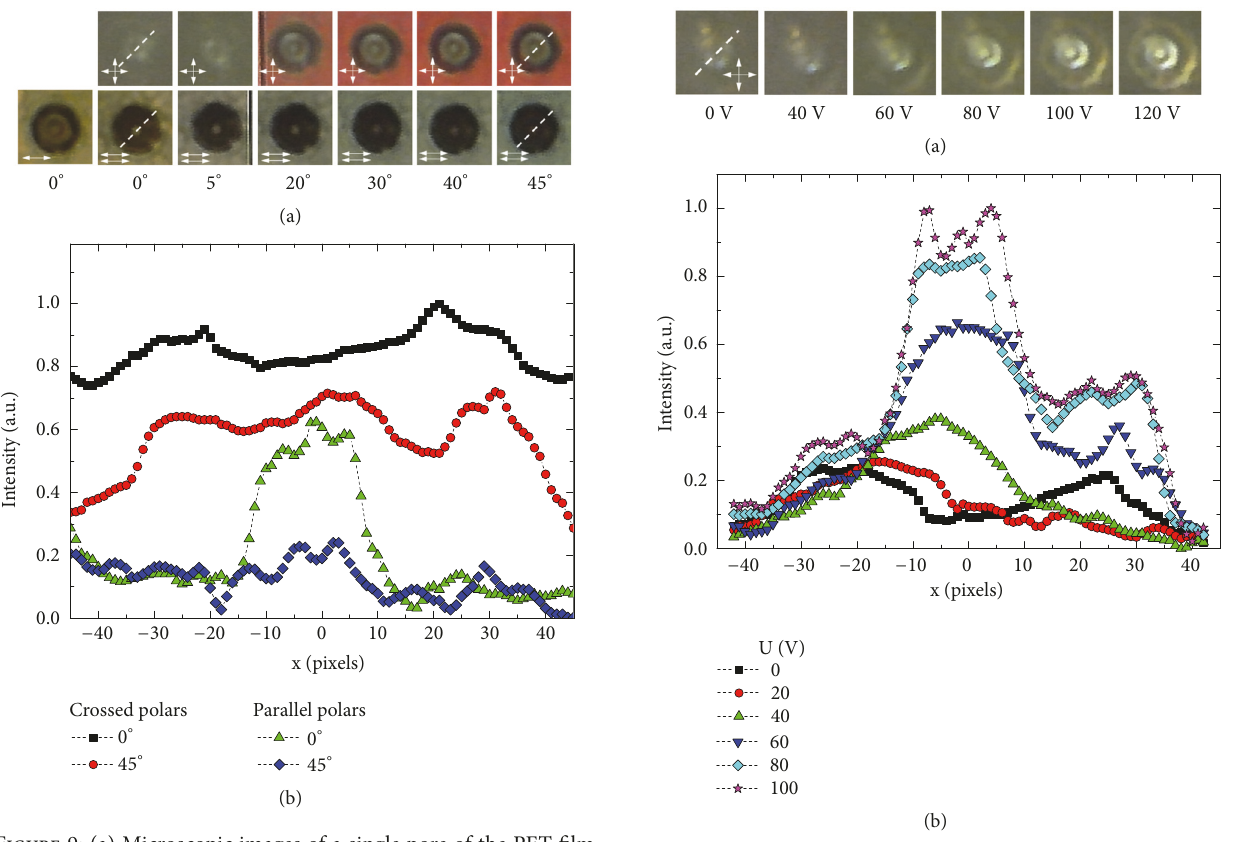
Figure 10: (a) Microscopic images of a single pore filled with LC for different values of the applied voltage (the voltage 𝑈 is ranged from 0 to 120 V and 𝑓 = 3 kHz) and (b) the intensity profiles measured along the dashed